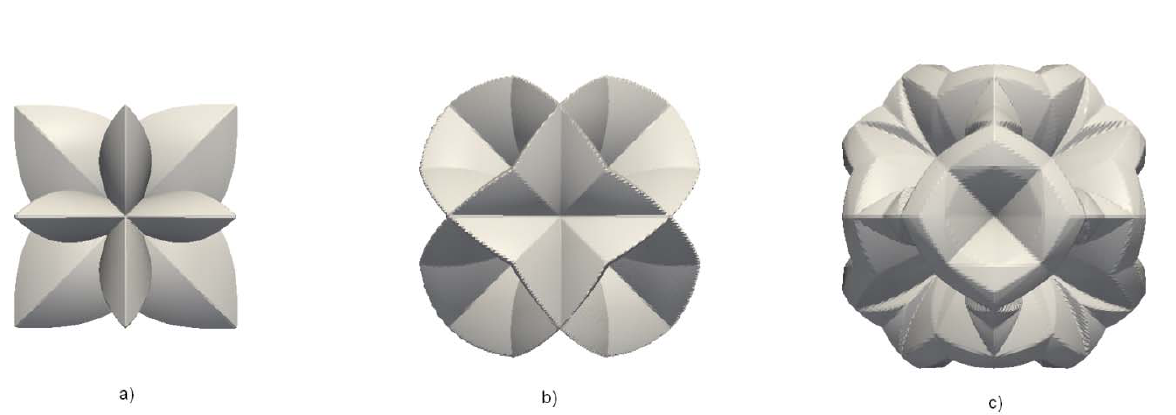
Figure 3. The angular dependence of the etching rate calculated using interpolation formulas with three (a), four (b) and thirteen (c) interpolation parameters (for 30% etchant concentration) listed in